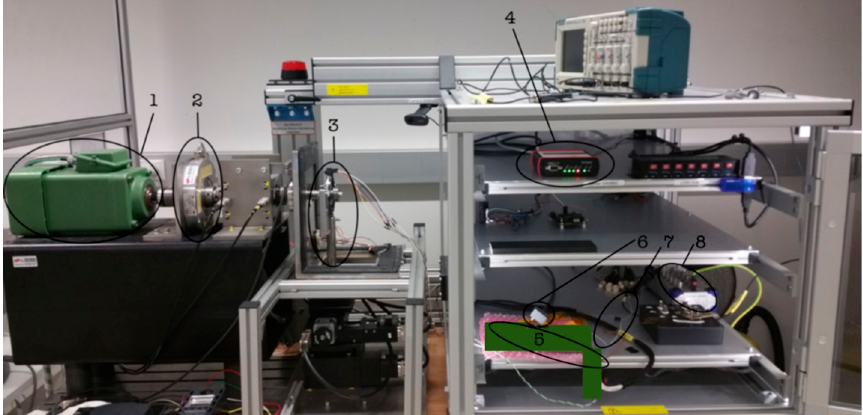
Figure 12. Test setup on the test bench using the electric drive (1), the reference sensor (2) and the DUT (3). The data acquisition is done by the ECU (5) where the POD (6) is polling the measured data. For evaluation of the synchronization approach, the mentioned trigger signal (7) is connected with the reference break ‐ out box (8).